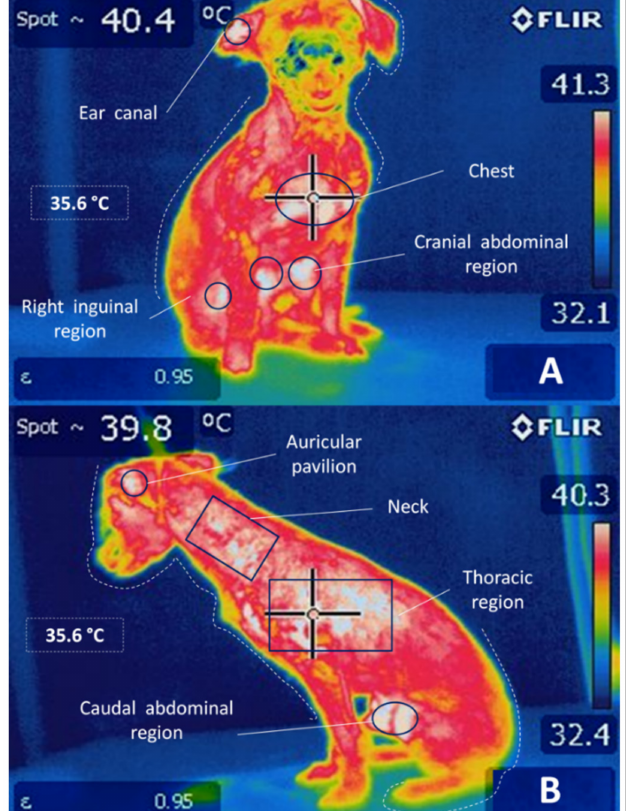
Figure 4. Canine thermograms in a resting state with increased surface body temperatures above normal. ( A ) (above) Temperatures above 41 ◦ C (above) are distinguished in the ear canal, chest, cranial abdominal region, and right inguinal region marked with circles. ( B ) (below) In this thermographic image seen from the side, temperatures above 40 ◦ C are appreciated, marked with circles in the pinna and the caudal abdominal region and rectangles in the thoracic and neck regions. The fact that the thoracic and abdominal areas have higher temperatures than the rest of the body surface indicates that a vasodilation response occurs in these regions that seek to dissipate excess body heat. In contrast, it can be seen that the entire periphery of the body surface (in yellow), marked with discontinuous white lines, shows a reduction in temperature by 5 to 6 ◦ C, compared to the areas marked in circles or rectangles of both thermograms. This decrease in temperature in the periphery indicates that the canine presents a process of peripheral vasoconstriction, characteristic of the onset of the febrile process, to increase the core body temperature and thus increase innate immunity for the destruction of the pathogen that caused the pyrexia. Images obtained with an FLIR E 50 camera equipped with an 18 mm FOL lens at a resolution of 240 × 180 pixels, (emissivity = 0.95, distance = 0.5